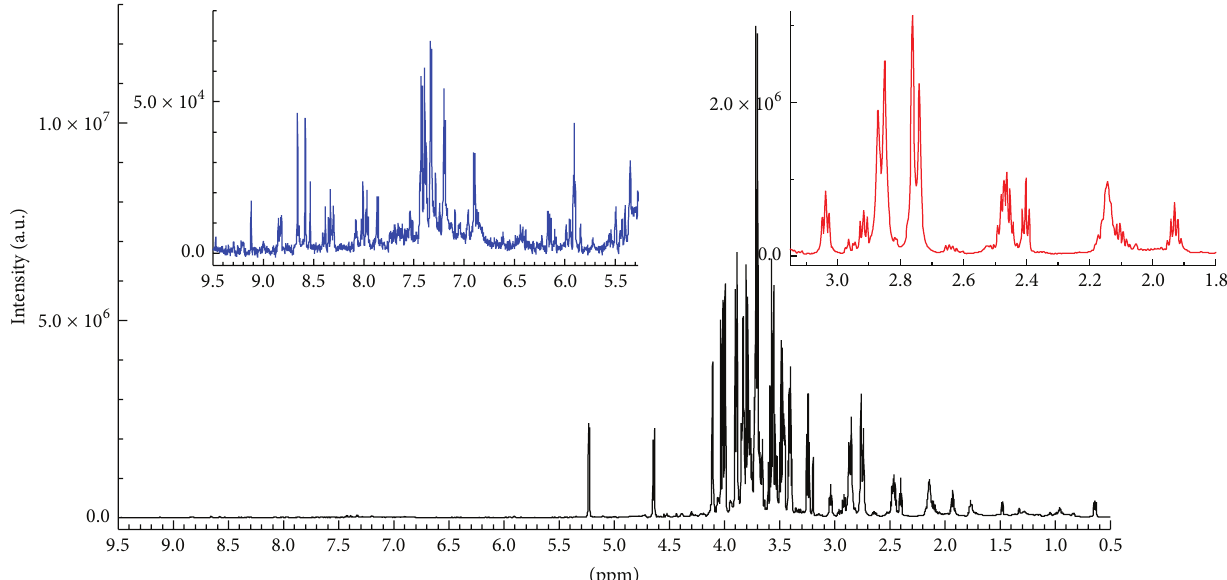
Figure 2: The complete typical proton spectrum of a PGI cherry tomato of Pachino sample is reported in the main plot. The expansions report the enlargement of the phenolic region (left side, blue line) and part of the aminoacidic region (right side, red